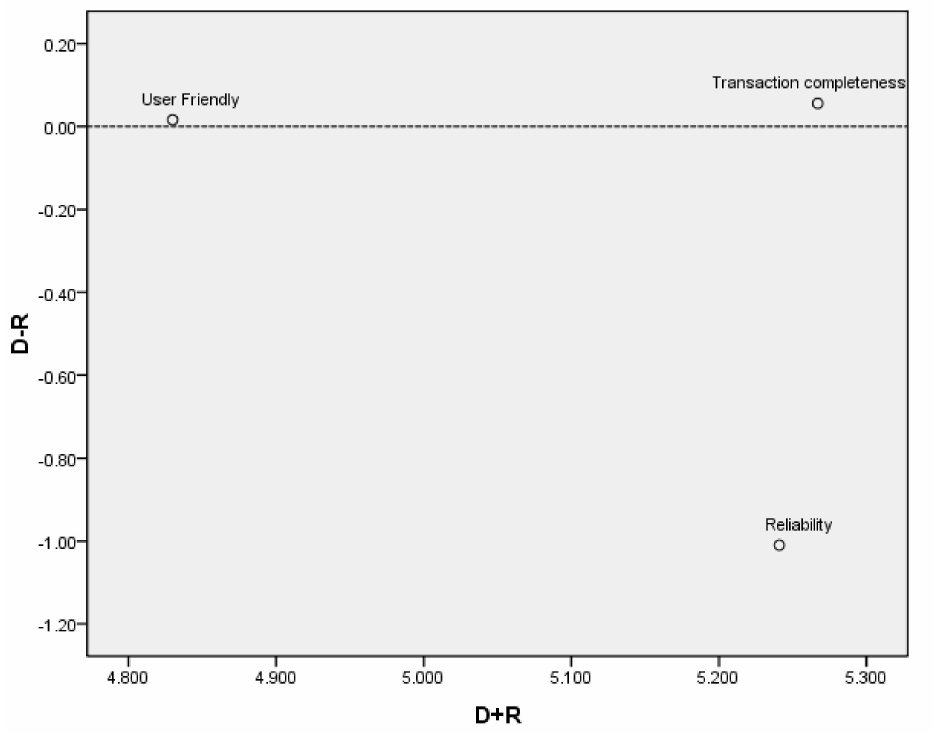
Figure 4. Graph of appearing causal relationships between the second tier criteria of the technolog- ical